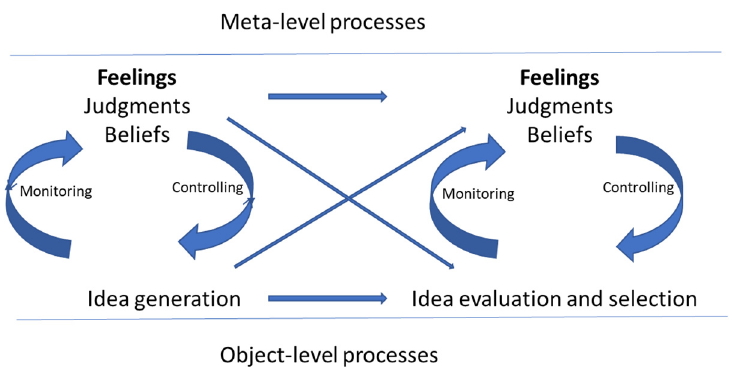
Figure 1. How feelings inform the creative process.